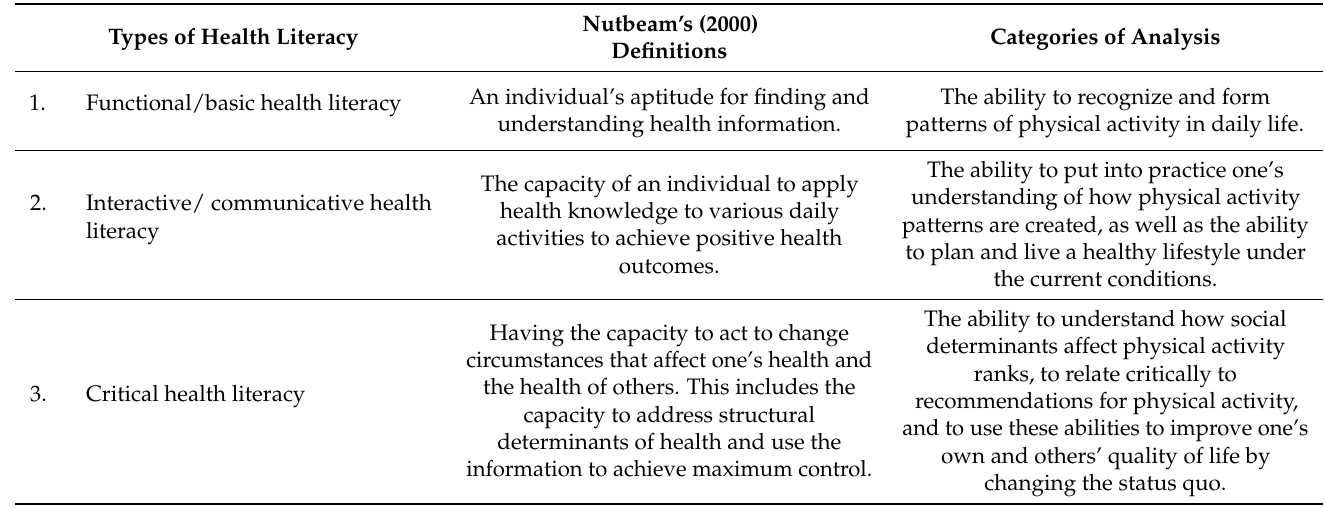
Table 1. Health Literacy